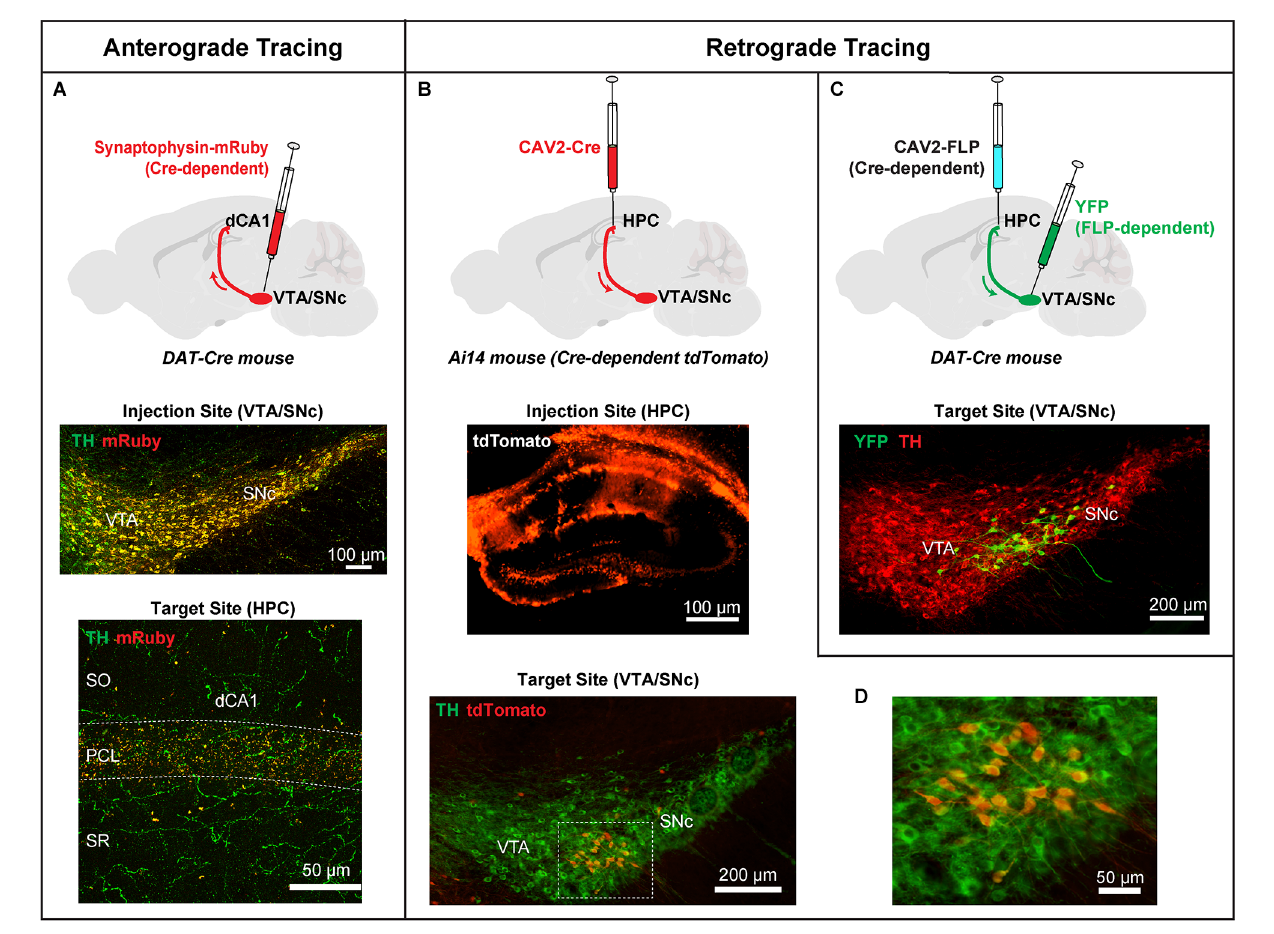
FIGURE1 Anterograde and retrograde viral tracing approaches to label direct projections from midbrain dopaminergic neurons to the dorsal hippocampus (HPC). (A) Top: An AAV expressing a Cre-dependent Synaptophysin-mRuby fusion protein was injected into the VTA/SNc of DAT-Cre mice to facilitate anterograde labeling of DA terminals originating from the midbrain. Middle: Coronal section of the site of injection in the VTA/SNc showing infection with Synaptophysin-mRuby (red), and DA cells labeled with an antibody against TH (green). Synaptophysin-mRuby infection is restricted to DA cells in this region indicated by the colocalization with TH (orange/yellow). Bottom: Coronal section of dCA1 showing punctate DA terminals expressing Synaptophysin-mRuby and TH (orange/yellow) demonstrating the extent of DA innervation from VTA/SNc. (B) Top: A CAV2 expressing Cre was